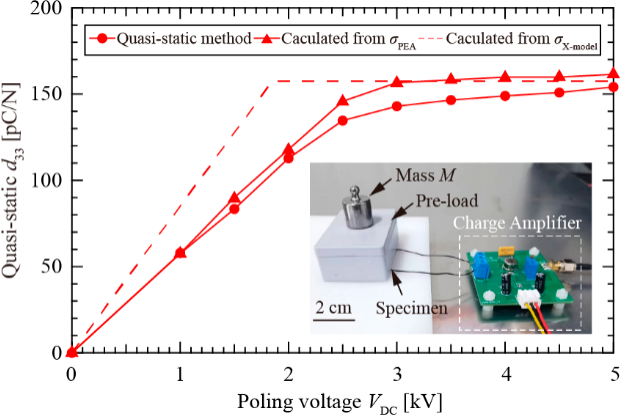
Figure 9. The dependence of quasi-static d 33 on the poling voltage ( V DC ) in cellular PTFE electrets .